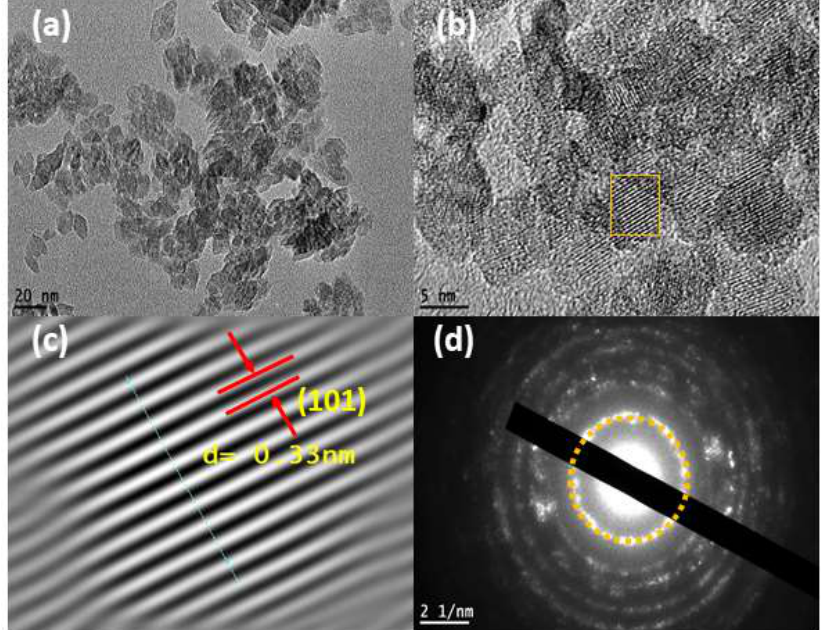
Figure 5. ( a , b ) TEM images, ( c ) HRTEM image, and ( d ) SAED pattern of the 5 nm TiO 2 nanoparticles.